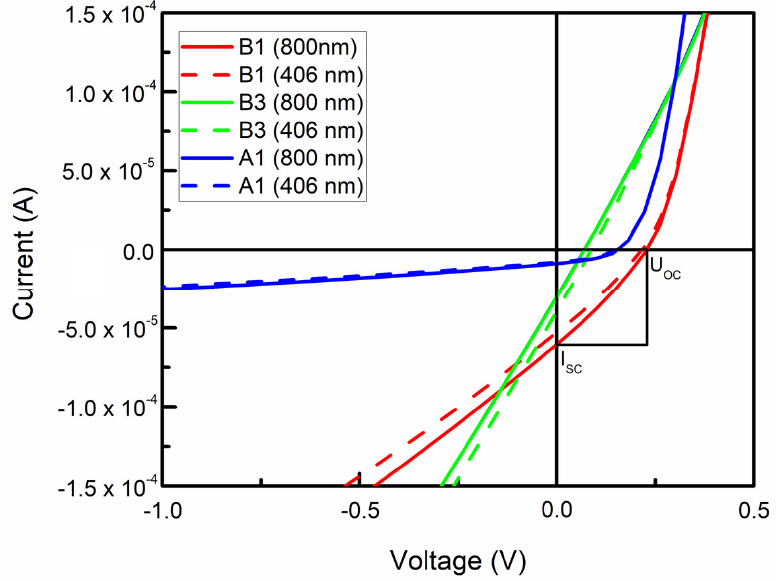
Figure 5. Typical I − V characteristics of directly synthesized graphene/Si heterojunctions measured under the illumination by 800 nm wavelength (solid) and 406 nm wavelength (dashed) LEDs.